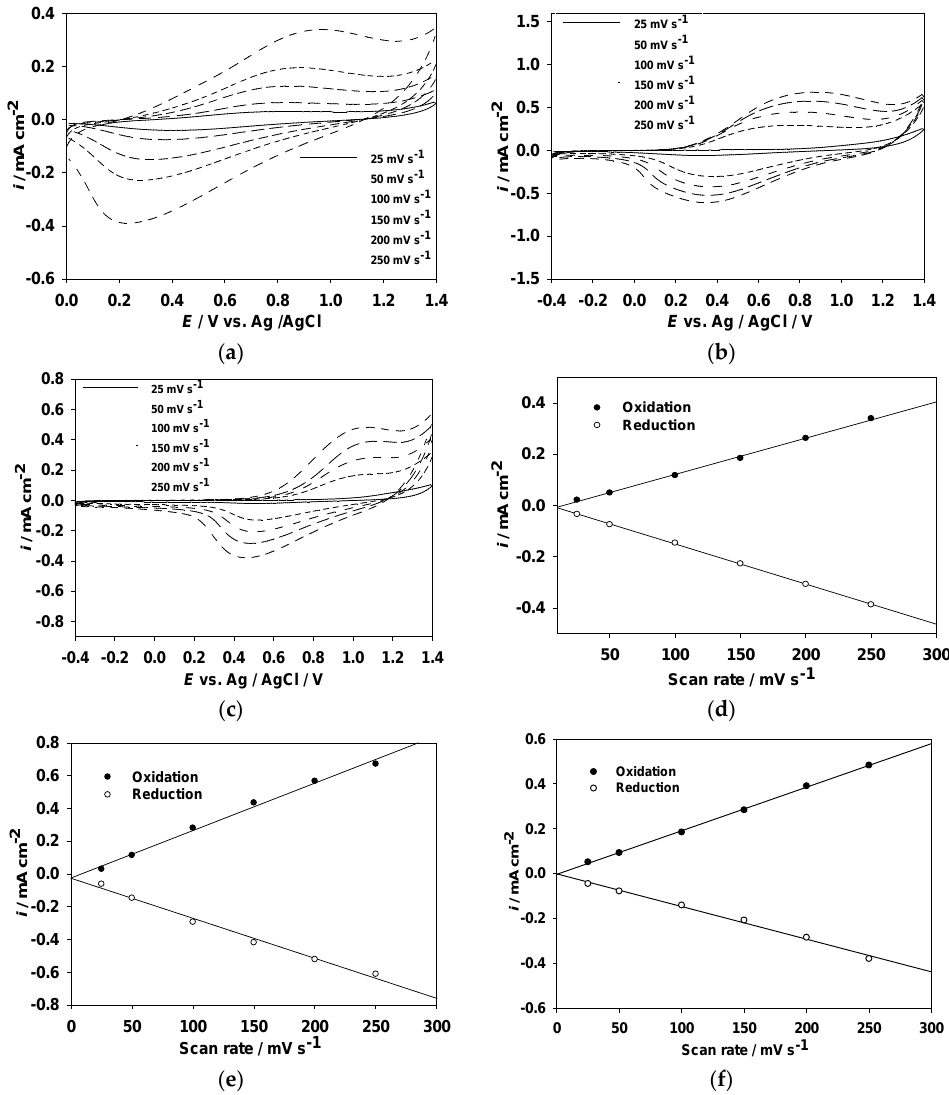
Figure 3. CV curves of ( a ) PMPS; ( b ) PMPO; and ( c ) PANIL films at different scan rates between 25 and 250 mV·s − 1 in 0.1 M LiClO 4 /EtOH solution, and the relationship between the peak current density and scan rate of ( d ) PMPS; ( e ) PMPO; and ( f ) PANIL films in 0.1 M LiClO 4 /EtOH